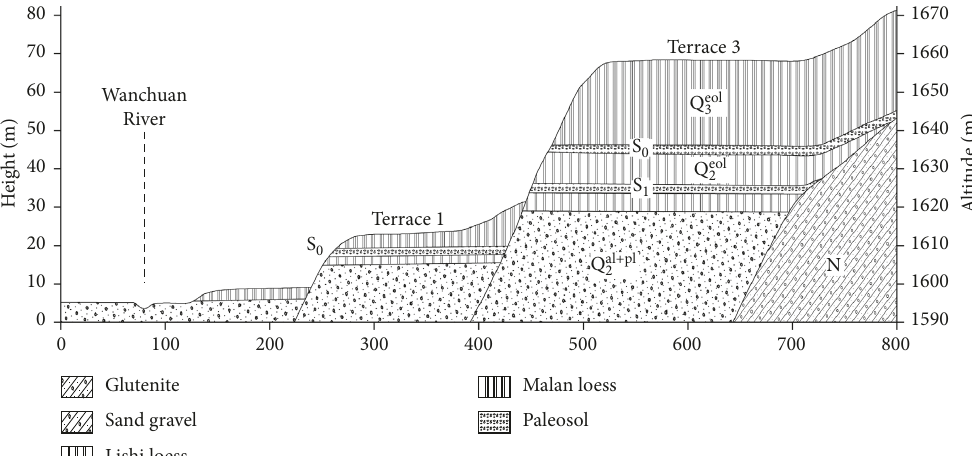
Figure 2: Terrace profile of Jinya Town, Wanchuan River (modified by Hu et al. [41]). On the right bank of the Wanchuan River is a typical stacked terrace. The experimental site is located on terrace 3, which is flat and open and covered with collapsible Malan loess thicker than